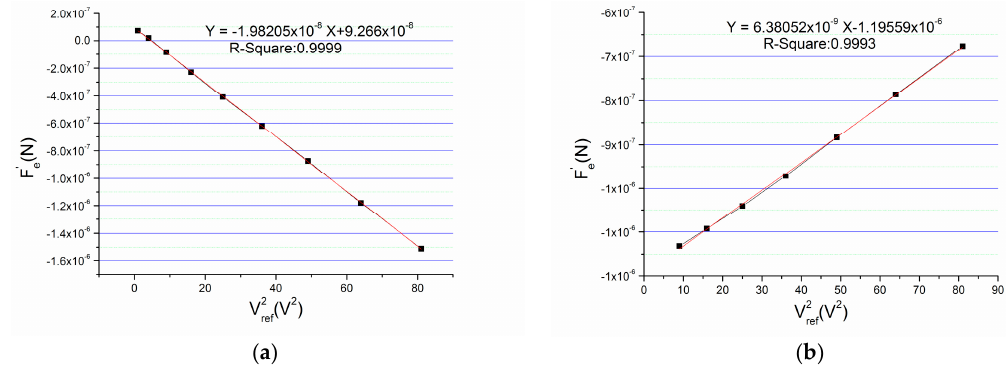
Figure 5. Mismatch of different circuit design: ( a ) result of before-optimization circuit; ( b ) result of